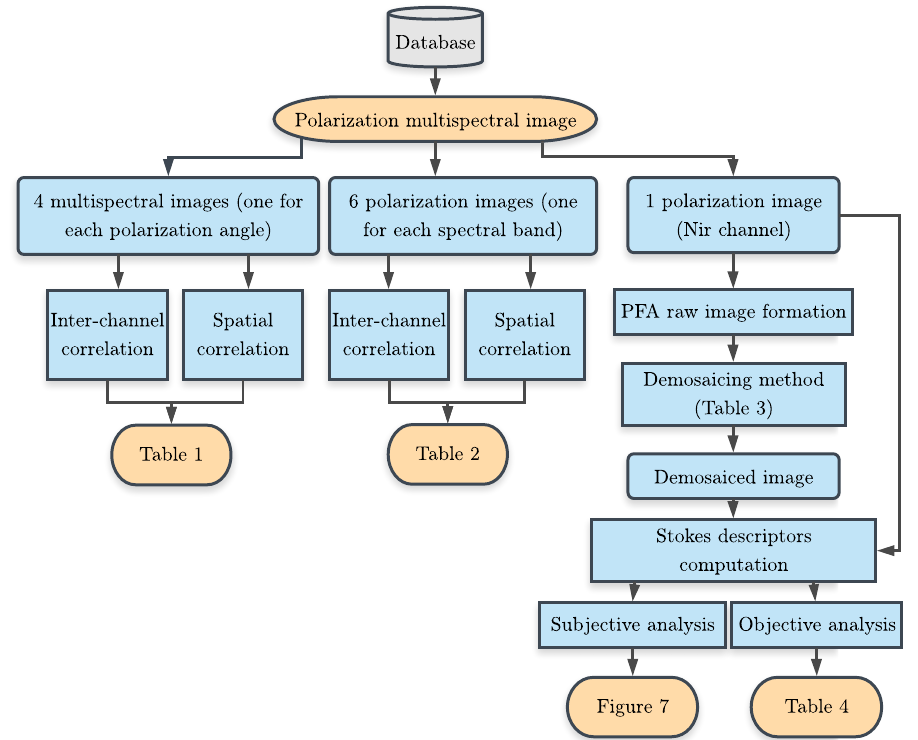
Figure 3. Overview of the analysis which is done in this